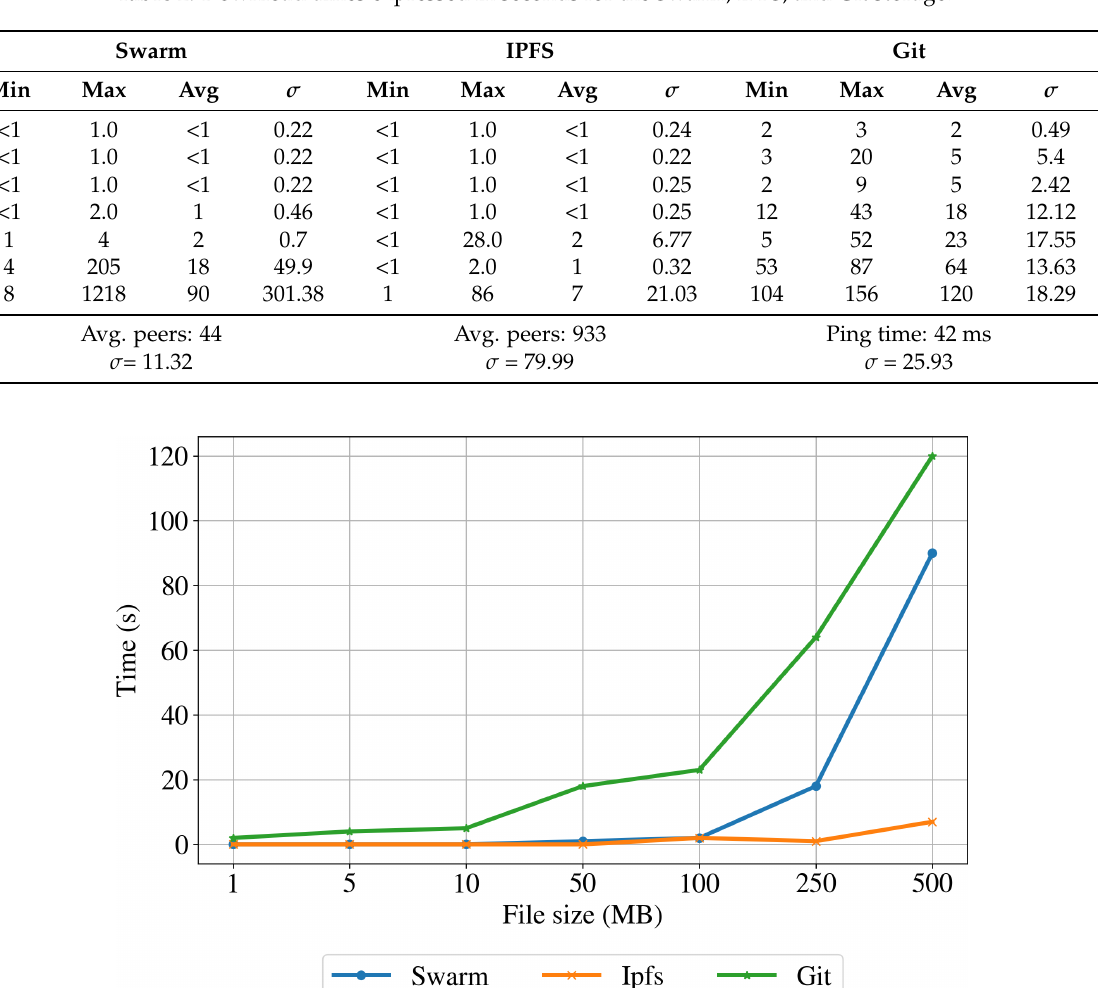
Table 2. Download times expressed in seconds for the Swarm, IPFS, and Git storage.